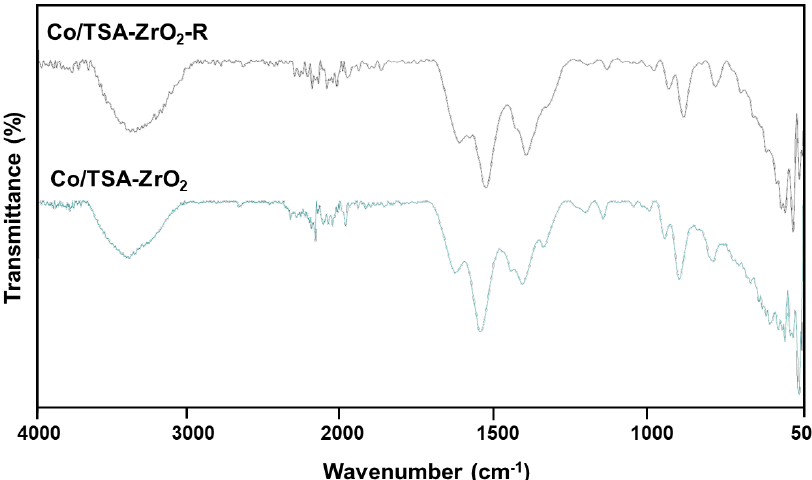
Figure 12. FT-IR of Co/TSA – ZrO 2 and Co/TSA – ZrO 2 -R.